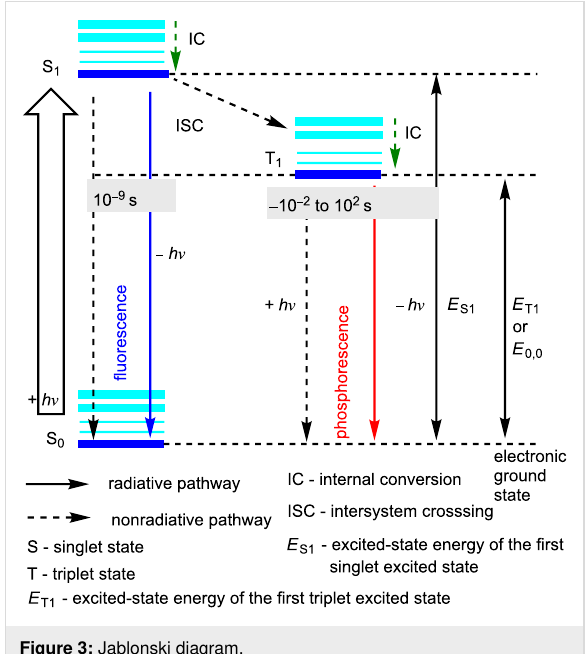
Figure 3: Jablonski diagram.